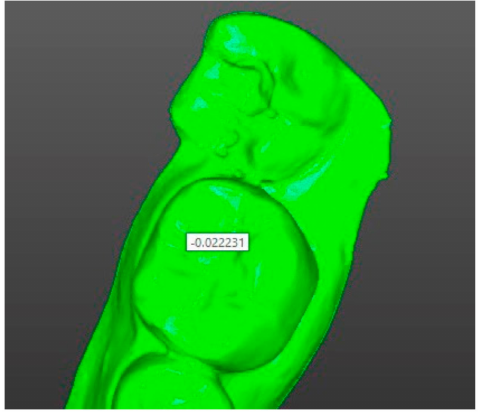
Figure 7. Numeric value of divergence in a chosen area.